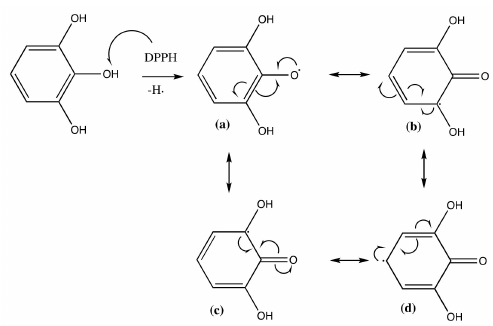
Figure 10. Radical electron delocalization by pyrogallol after hydrogen abstraction by free radical.